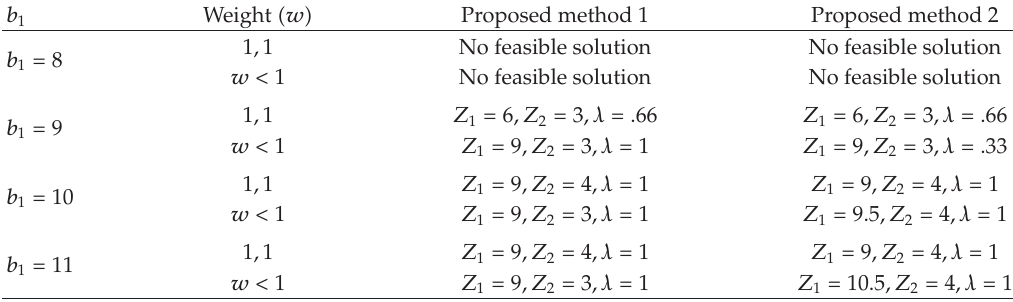
Table 12: Solution of the FLGP problem by varying the resource of the first constraint. b 1 Weight (cid:2) w (cid:3) Proposed method